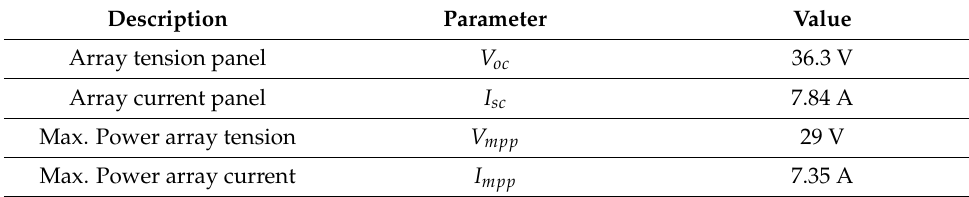
Table 2. Photovoltaic panel parameters.